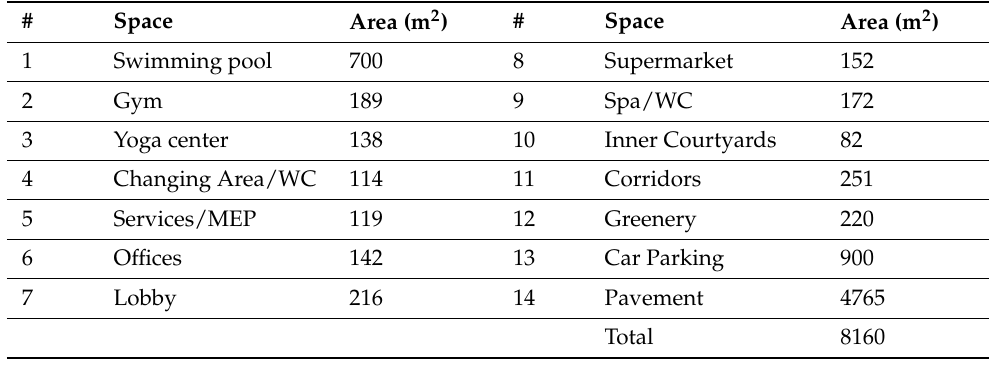
Table 3. Total area of the new design.